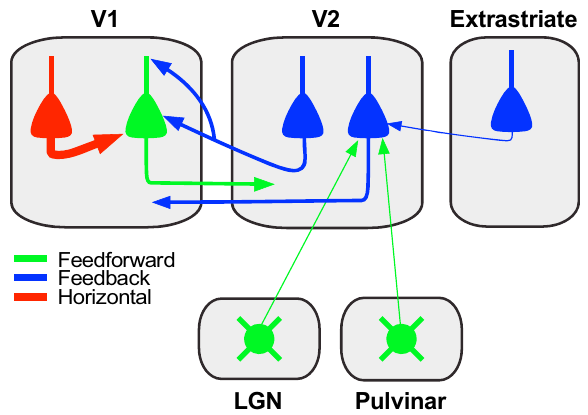
Fig. 9 Summary circuit model. Schematics of the FB circuit motifs were discovered in this study. Triangles: pyramidal cell somata; circles: thalamic cell somata; arrows: axonal projections (thickness indicates projection magnitude). All axonal projections in this scheme are excitatory and terminate onto excitatory cells. Some V2 FB neurons (left V2 blue cell) make monosynaptic contacts with V1 neurons projecting to V2 (green pyramidal cell). The latter receive the majority of their long-range cortical inputs from other pyramidal neurons within V1 (red cell). Some V2 neurons in L5 (right V2 blue cell) sending FB to V1 receive monosynaptic inputs from FB neurons in higher extrastriate areas (blue cell in the extrastriate cortex), as well as sparse inputs from the LGN and lateral pulvinar (round green